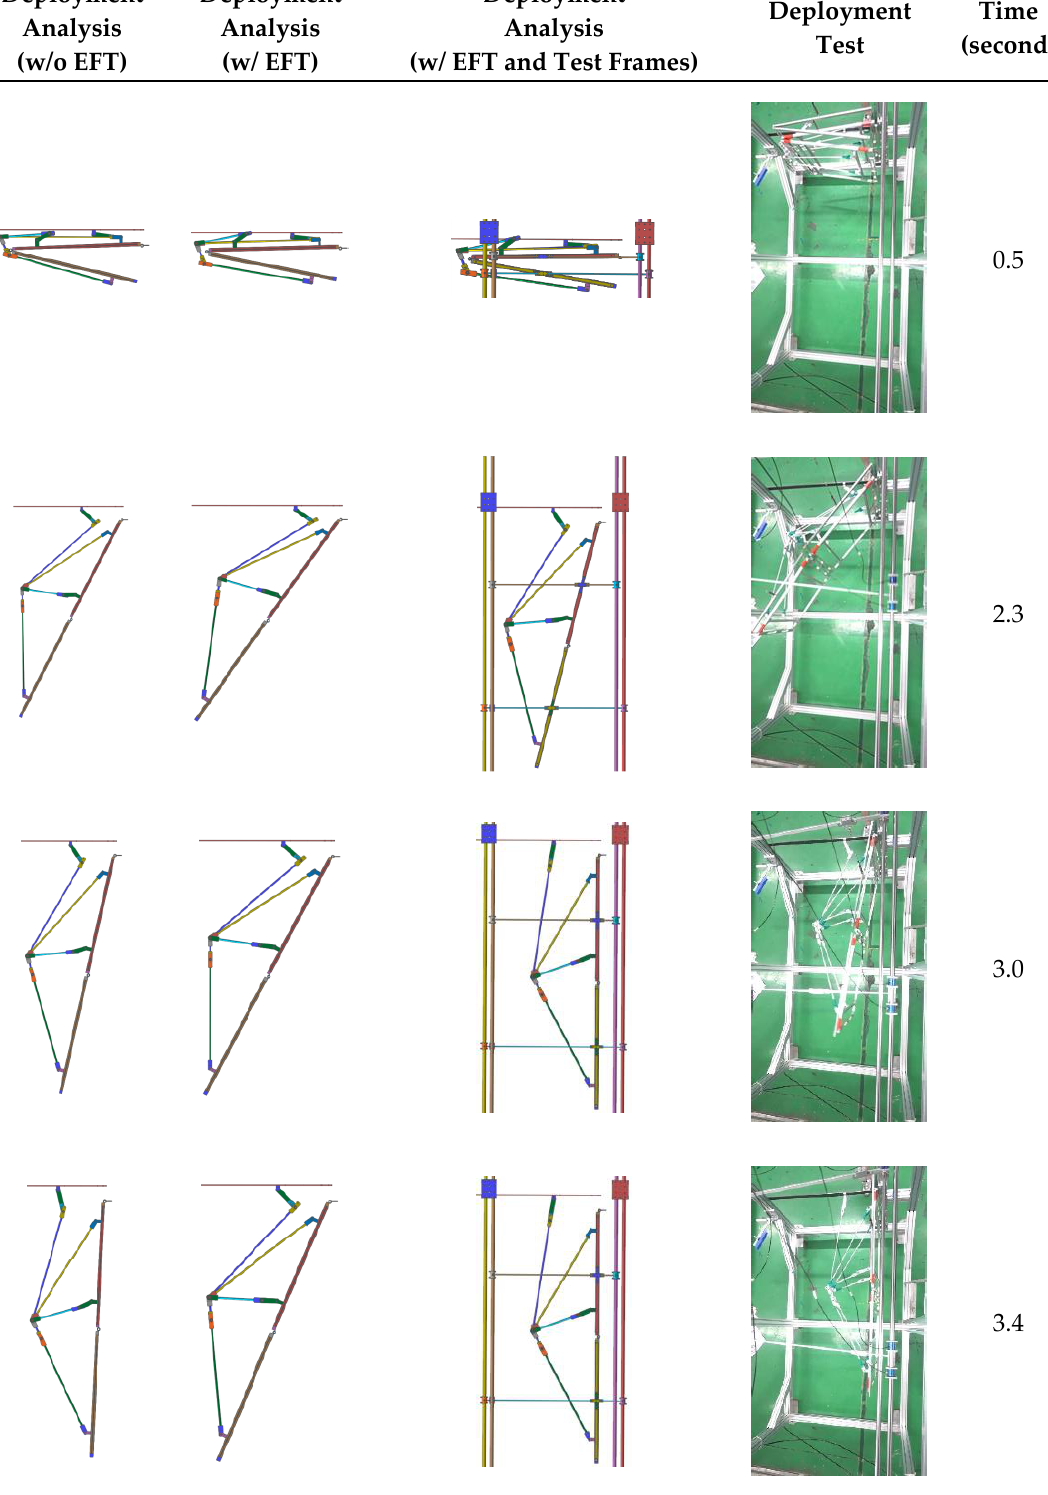
Figure 14. Comparison of the deployed motion history for case 3.